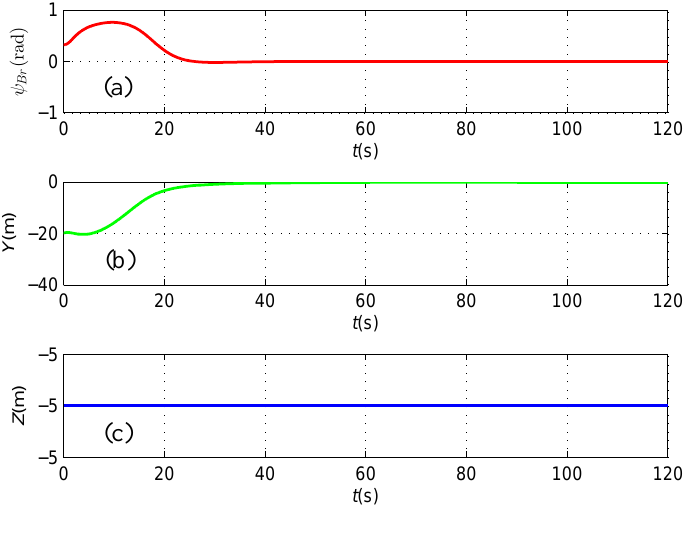
Figure 9. ( a ) The angle ψ Br between the AUV heading and the direction of the cable; ( b ) The horizontal offset Y between the AUV and the cable; and ( c ) The vertical distance Z between the AUV and the